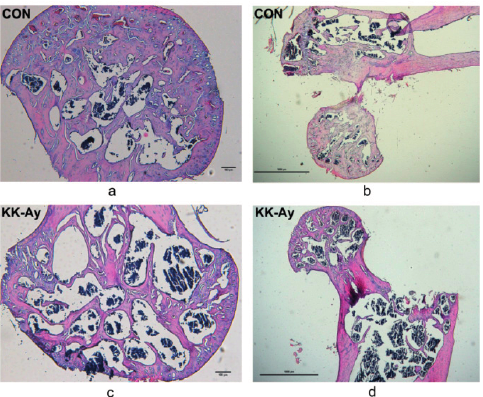
Figure 3. Histology photomicrographs showing H&E staining of the micro-structure of cancellous bone in demineralized paraffin sections. Representative photographs of histological sections from the proximal femora in control ( a , b ) and KK-Ay mice ( c , d ). Scale bar: 100 μ m in ( a , c ) and 1000 μ m in ( b , d